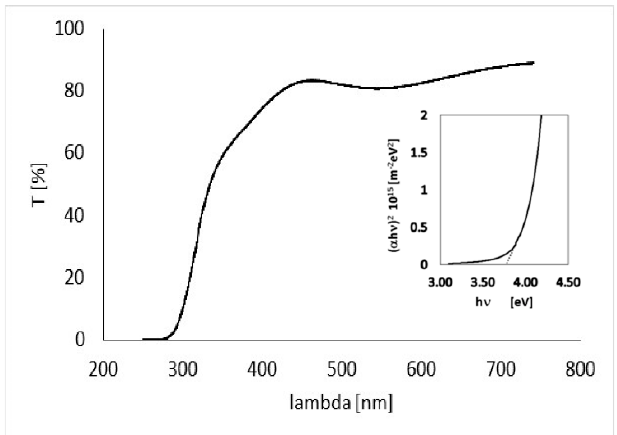
Figure 3. Optical transmission of a In 2 O 3 230 nm-thick film on glass substrate.